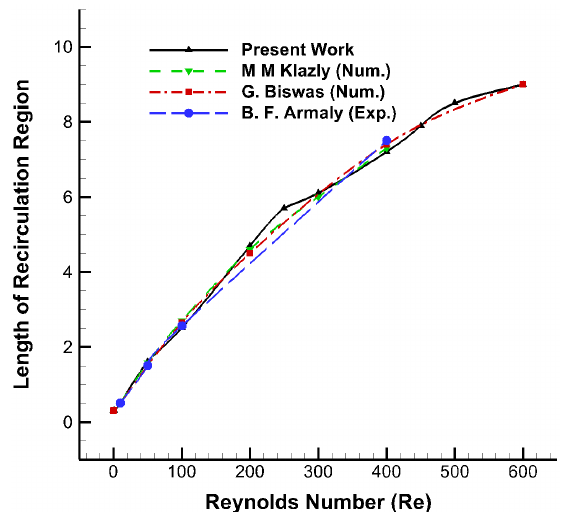
Figure 2. Length of the primary recirculation region behind backward facing step having an expansion ratio of 1.9423 for flow of water compared with Armaly [6], Biswas [7] and Klazly [71].